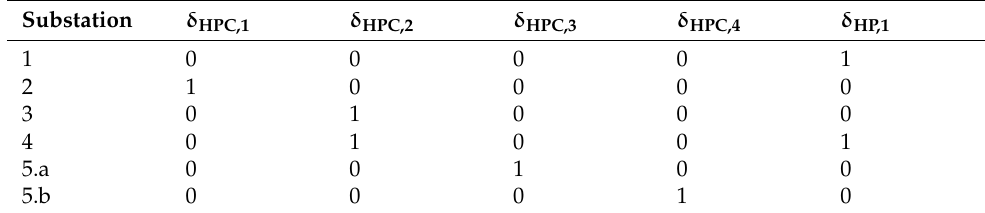
Table 4. Association of substation, HPC, and HP operation